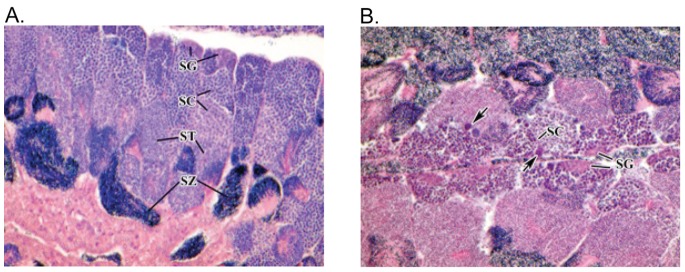
Comparative testicular morphology.A) Normal testicular morphology of male silverside collected at the ranch site; B) abnormal testicular morphology of male collected at the urban site showing severe germ cell necrosis (arrows) at the spermatocyte (SC) stage. Samples prepared in H&E paraffin section. SG = spermatogonia; SC = primary and secondary spermatocytes; ST =  spermaids; and SZ = spermatozoa.